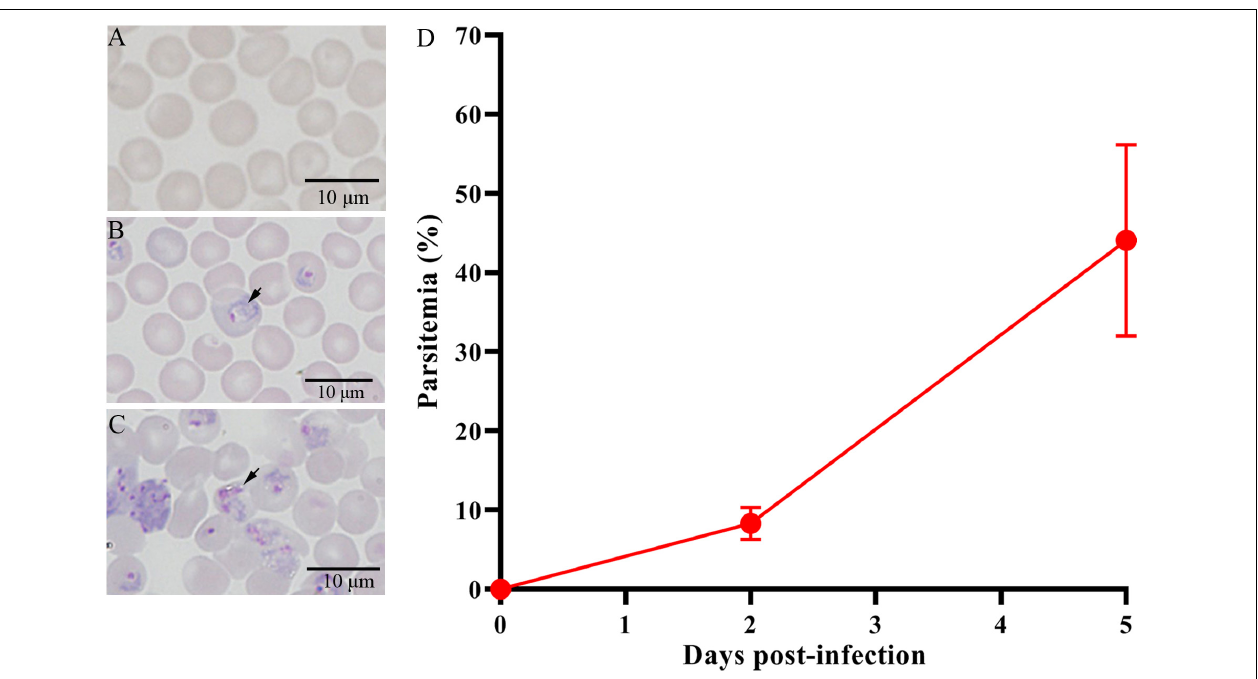
FIGURE 1 | Giemsa’s stain to determine the parasitemia of Py 17XL in BALB/c mice. (A) The control mice (Ctrl) without parasite infection. (B) The PyD2 group with successful parasite infection at 2 dpi. (C) The PyD5 group with successful parasite infection at 5 dpi. (D) Percent parasitemia was evaluated on the corresponding days. Data are cumulative results ( n = 16 mice per group) from two